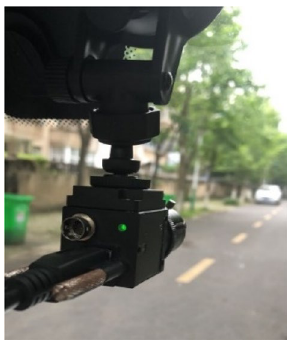
Fig. 2 Installation of the vehicle-mounted camera